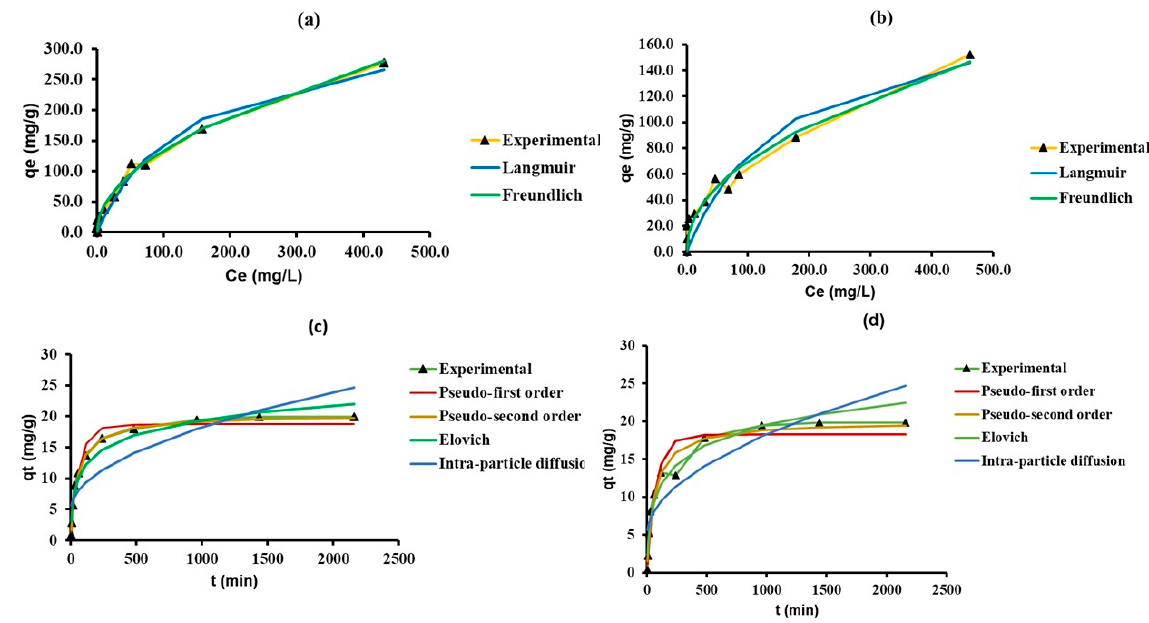
Figure 2. Comparison of experimental and model predicted adsorption capacity (mg g − 1 ) values in various non-linear isotherm models; ( a ) nZVI-Bare, ( b ) nZVI-Bento and kinetic models, ( c ) nZVI-Bare, and ( d ) nZVI-Bento.